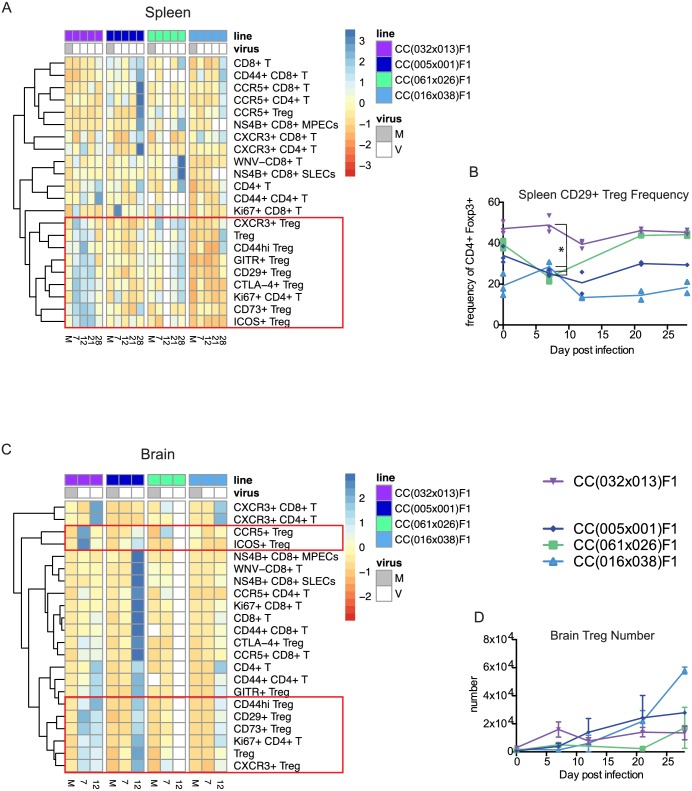
Chronic infection model mice show increased splenic Tregs over the time course of WNV infection compared to mice with disease.(A) Three representative RIX lines with disease are compared to the chronic line, with T cell subsets and activation markers measured by flow cytometry as indicated (blue = up, red = down); data from spleen. (B) CD29+ Treg frequencies in the spleen. At d7 post-infection, differences in spleen CD29+ Treg frequency were statistically significant for CC(032x013)F1 compared to CC(005x001)F1, CC(061x026)F1, and CC(016x038)F1 (p<0.005). (C) Flow cytometry analysis heat maps from brain samples for the same lines and time points. (D) Brain Treg numbers. N = 3 mice per group for all time points shown.